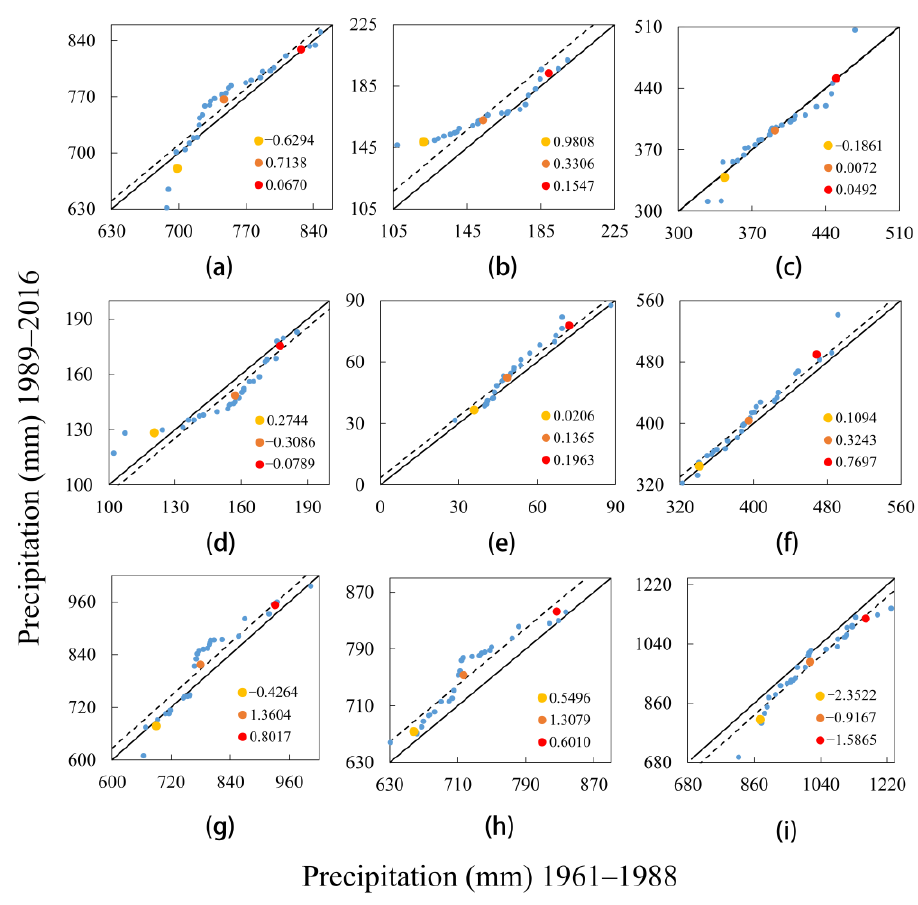
Figure 10. Results of innovative trend analysis (ITA) for precipitation over the whole JRB: ( a ) annual, ( b ) spring, ( c ) summer, ( d ) autumn, ( e ) winter. Annual precipitation in the sub-basins ( f ) SRJRB, ( g ) UPJRB, ( h ) YLRB, and ( i ) MLJRB. Yellow, orange, and red points denote the mean central points of the low, medium, and high categories, respectively.